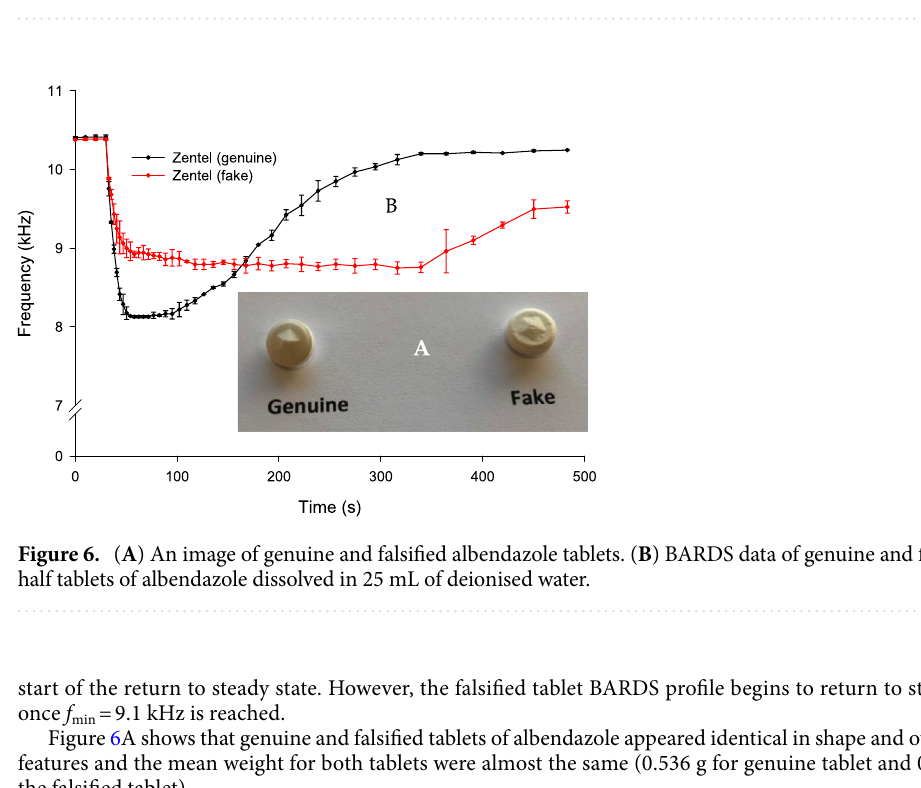
Figure 5. ( A ) An image of genuine and falsified paracetamol/caffeine tablets. ( B ) BARDS data of genuine and falsified paracetamol/caffeine half tablets dissolved in 25 mL of deionised water.